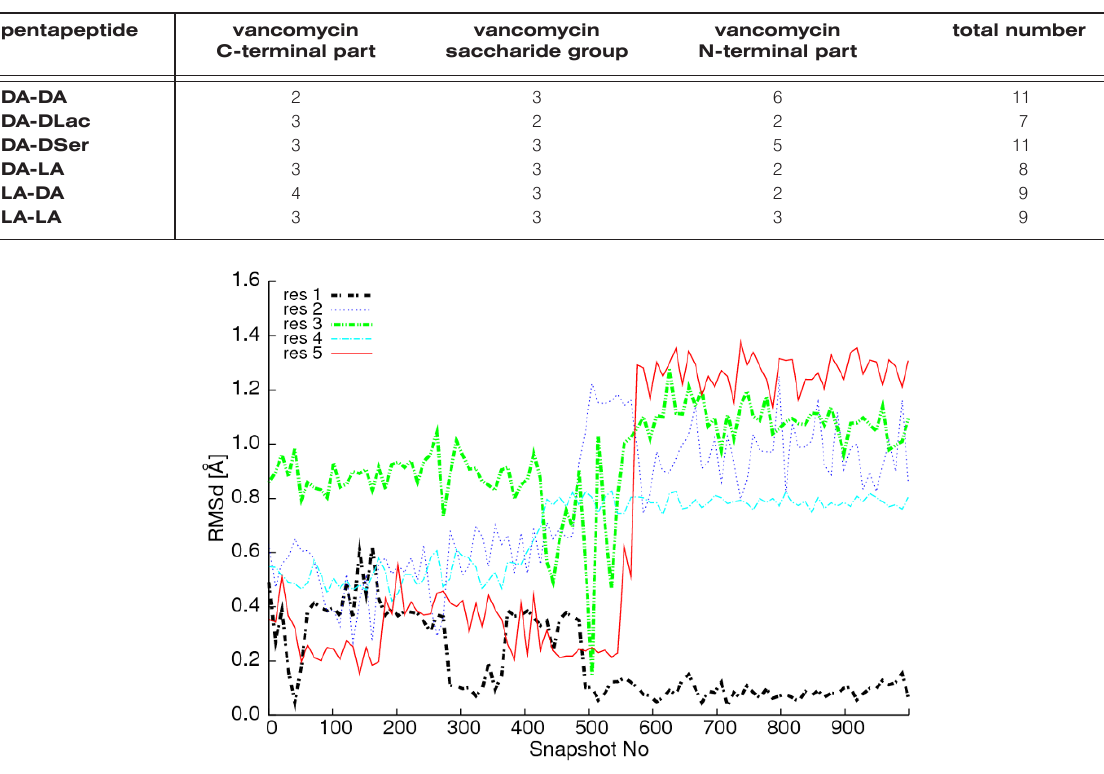
Figure 5. Plot of RMSd changes of DA-LA during unconstrained